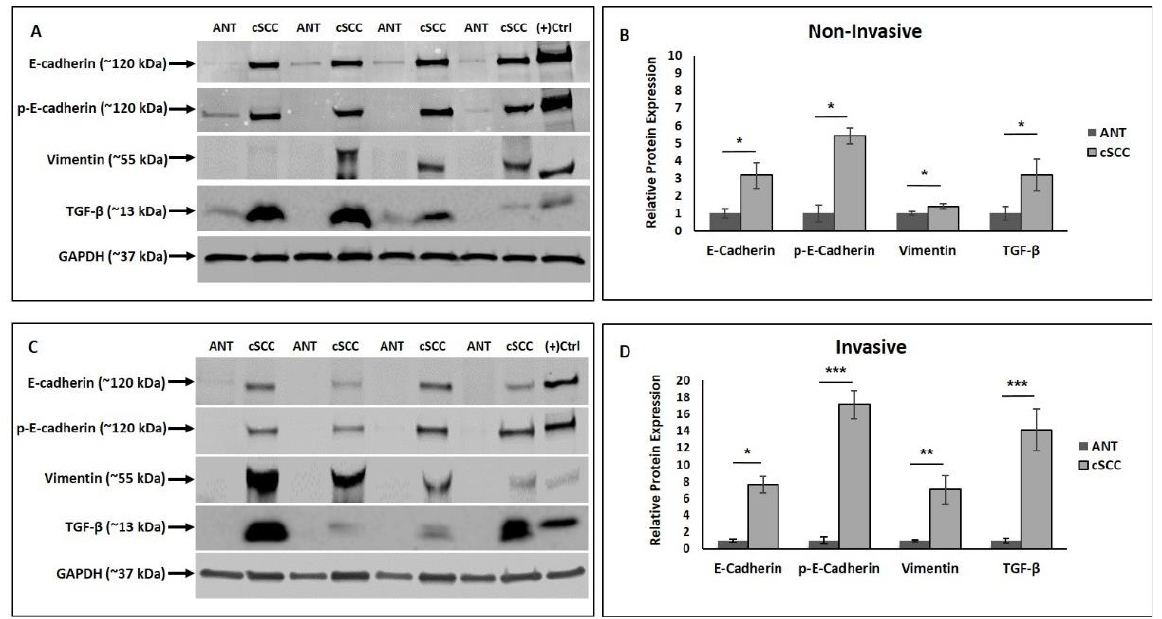
Figure 3. Western blot analysis of the epithelial markers E-cadherin and phosphorylated E-cadherin, the mesenchymal marker vimentin, and TGF- β protein expression in non-invasive (Panels A , B ) and invasive (Panels C , D ) cSCC tissues compared to ANT. Positive control lane: P-cadherin for the cadherins and HeLa cell lysate for vimentin and TGF- β . All values are expressed as mean ± SEM. * denotes p < 0.05, ** denotes p < 0.01, and *** denotes p < 0.001.